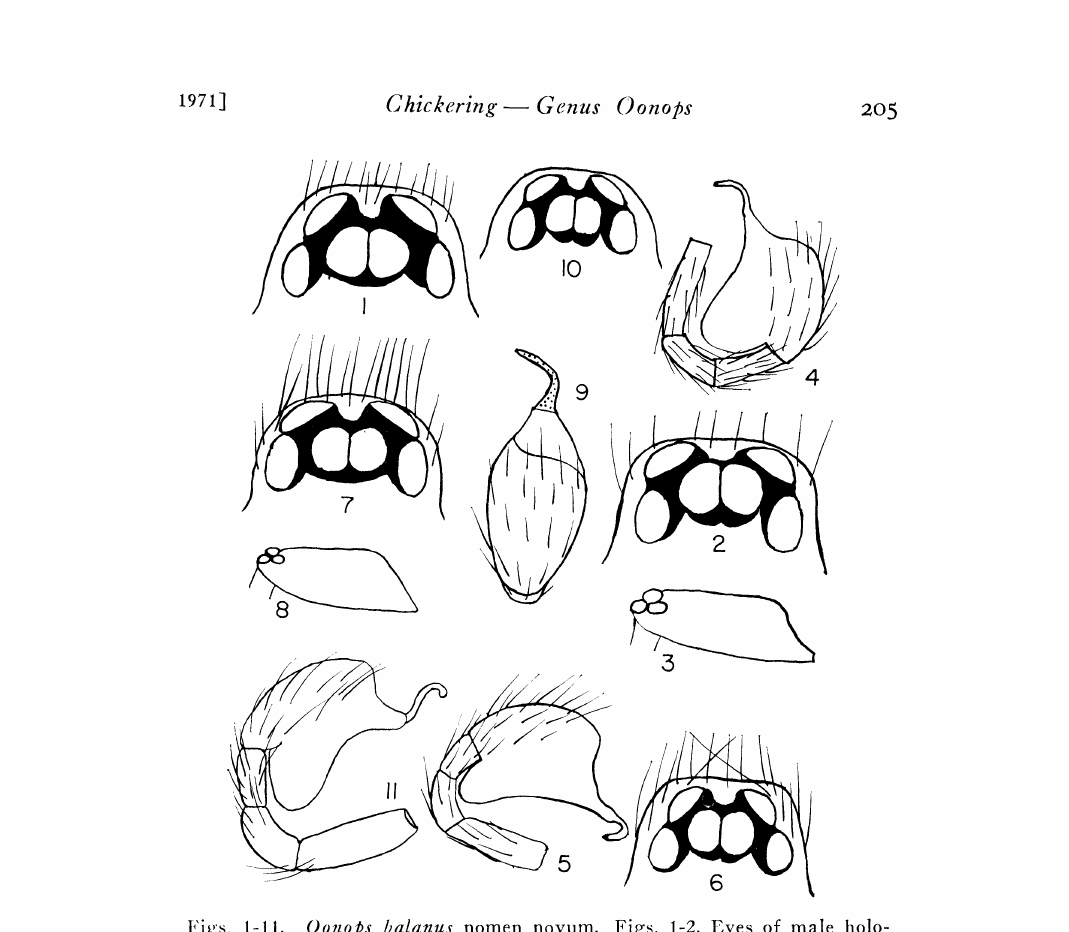
Figs. 1-ll. Oonops balanus nomen novum. Figs. 1-2. Eyes of male holo- type and female paratype, respectively; viewed from above. Fig. 3. Cara- pace of male holotype; left lateral view. Fig. 4. Palp of male holotype; lateral view. Figs. 5-6. Left palp of male, prolateral view and eyes of male from above, respectively; from St. Croix, V. I., Sept., 1966. Figs. 7-8. Eyes of male from above and carapace of male, left lateral view, respec- tively; from Virgin Gorda, B. V. I., Aug., 1966. Fig. 9. Right palpal tarsus of male, nearly dorsal view; from Virgin Gorda, B. V. I., Aug., 1966. Figs. 10-11. Eyes of male from above and left palp of male, prolateral view, respectively; from So. Bimini, Bahama Ids.,